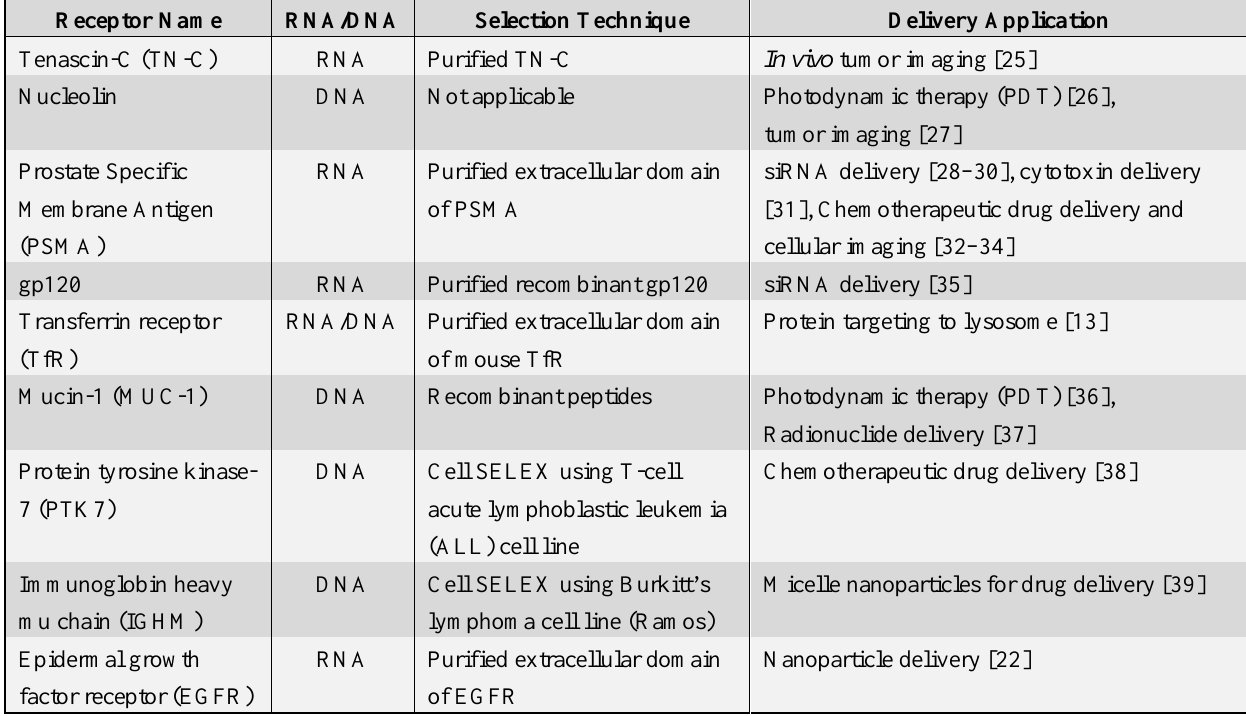
Table 1. Cell surface protein aptamers and their